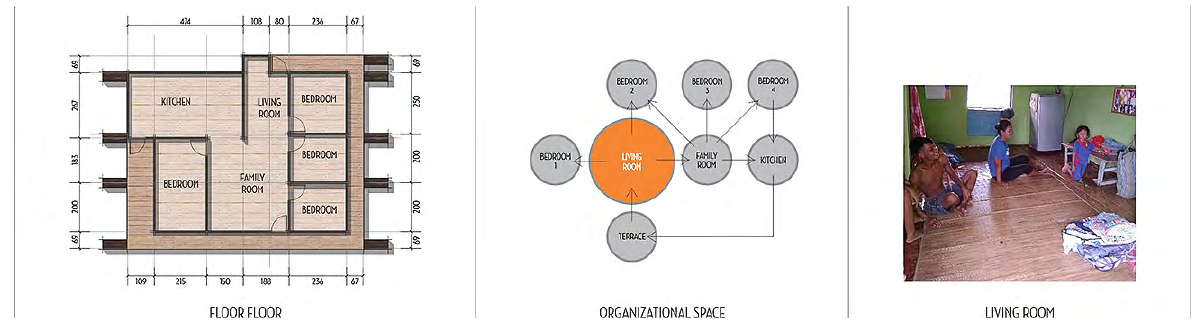
Figure 12. (a) Floor plan case 4; (b) Organizational space case 4; (c) Living room case 4